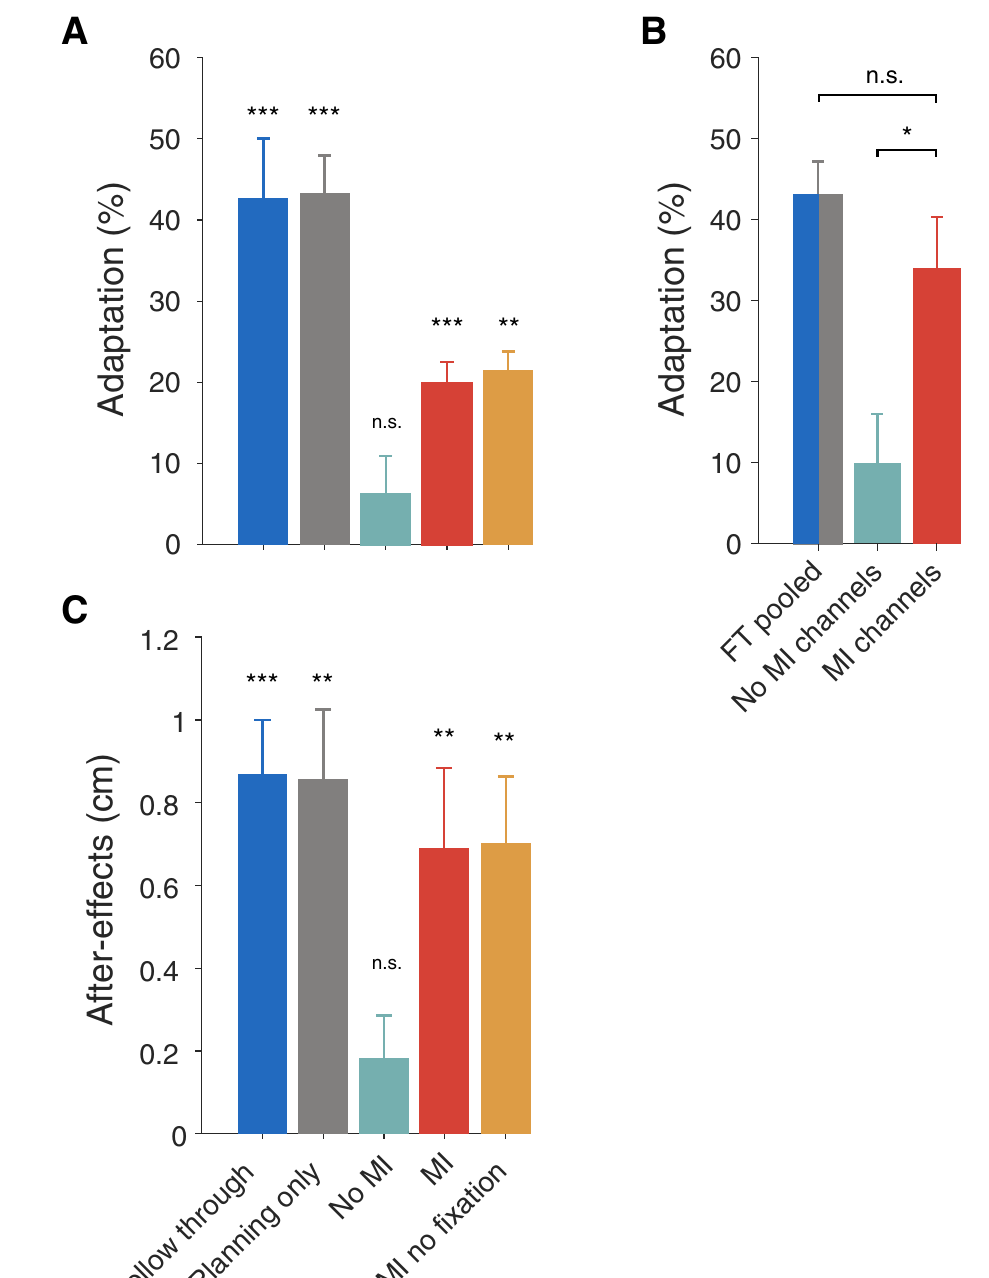
no-imagery group was a consequence of co-contraction or other non-specific strategies. The absence of adapta- tion in the no imagery group is consistent with many studies which have shown that static visual cues are insuffi- cient to reduce interference to opposing force fields 1,3–6 . Our results suggest that just imagining the follow through movement allows the separation of motor memories.